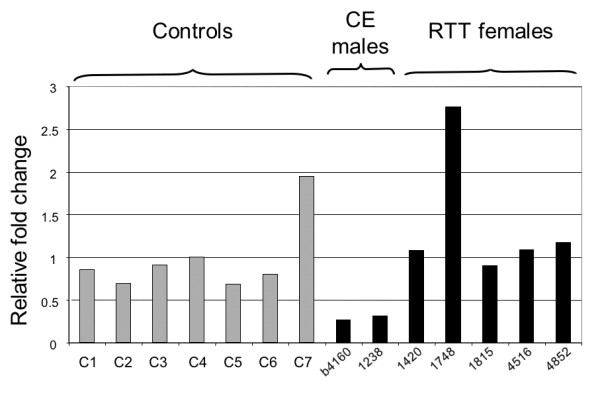
Relative FXYD1 expression in human frontal cortex. Quantitative real-time RT-PCR analyses were carried out on frozen frontal cortex samples from seven unaffected controls (C1 – C7), two MECP2-mutant males with congenital encephalopathy (CE) and five females diagnosed with RTT, with or without identified MECP2 mutations. The mutant samples are identified by their brain bank numbers. FXYD1 expression was normalized to RPS18, a constitutive ribosomal protein gene that is expressed at a similar level in brain. To calculate relative fold changes, control sample C4 was arbitrarily set at 1. All samples were run in triplicate on the same plate.